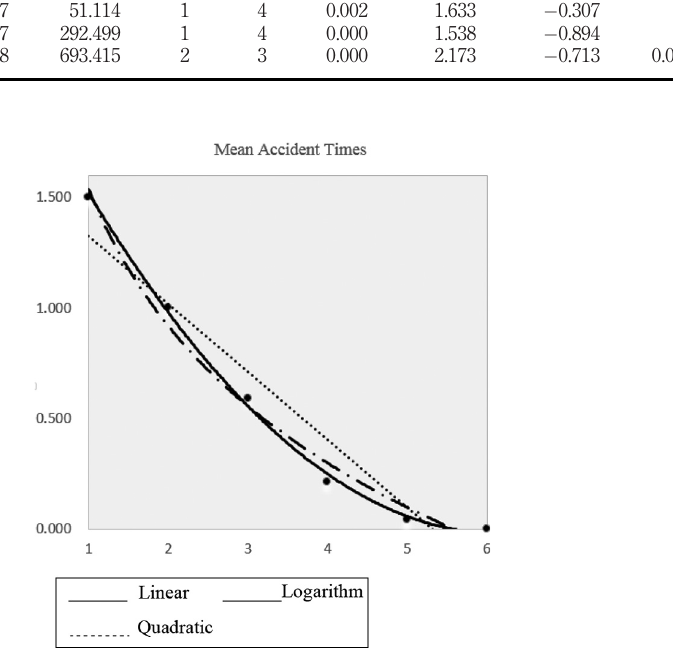
Table VII. The fi tting results of